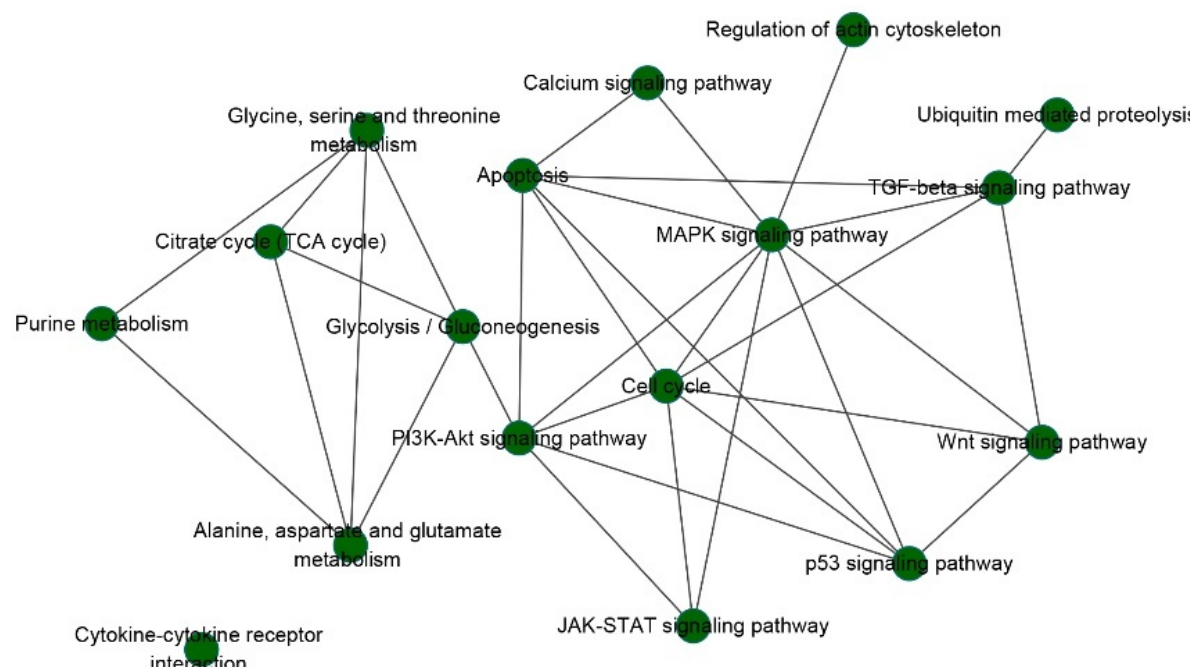
Figure 6. Pathway-pathway association network for the prognosis pathways and their related pathways.